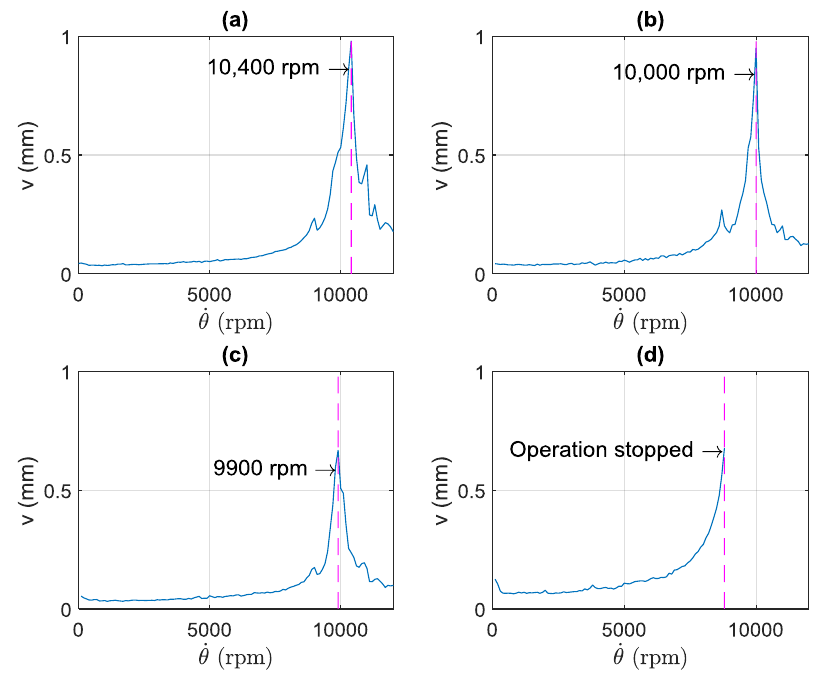
Figure 5. Raw displacement data from the shaft for different sleeve configurations: ( a ) no sleeve, ( b ) short sleeve, ( c ) medium sleeve and ( d ) long sleeve.